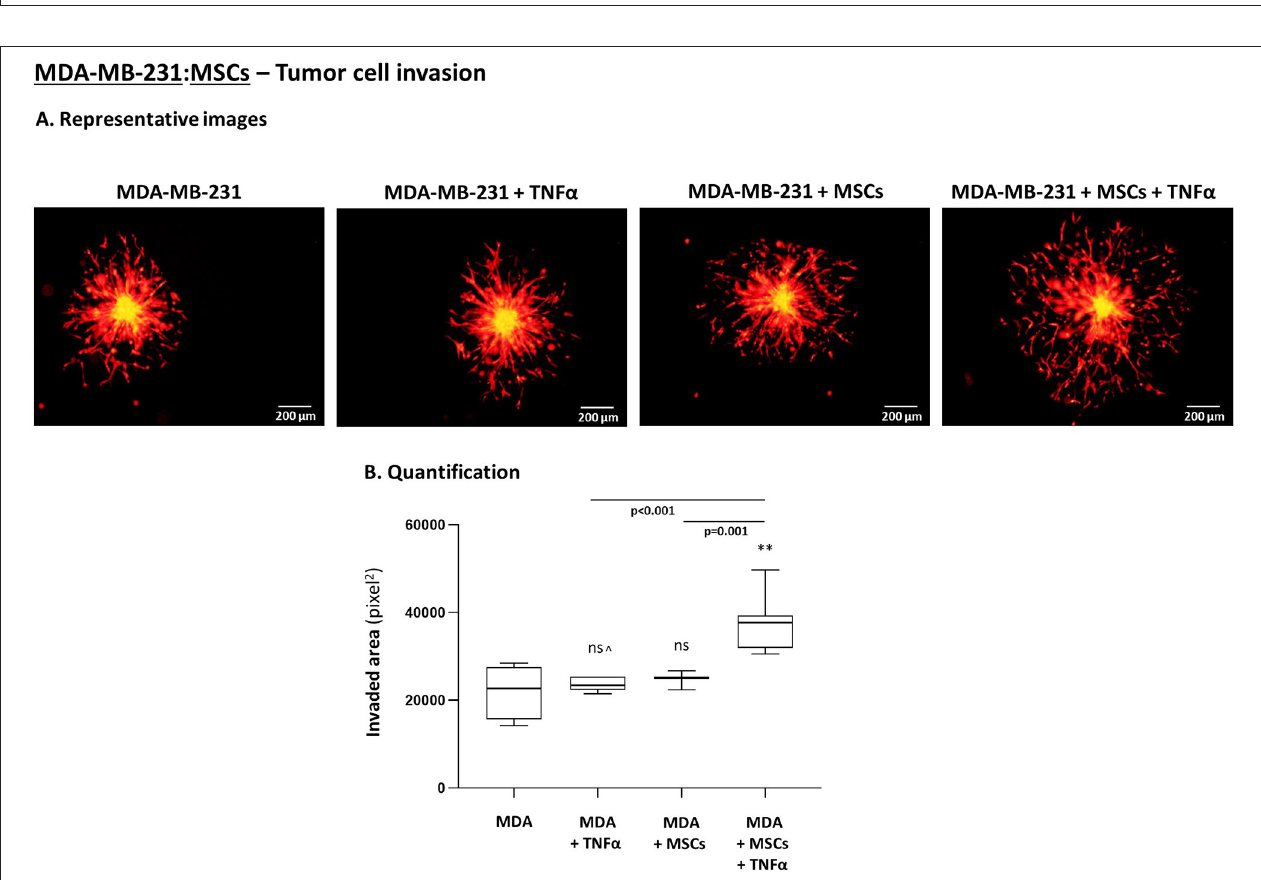
FIGURE 10 | TNBC cells acquire elevated invasive properties upon “Contact” co-culturing with MSCs in the presence of TNF α . The Figure demonstrates tumor cell invasion out of 3D spheroids that were formed by mCherry-MDA-MB-231 cells (“MDA”) alone or by tumor cells in “Contact” co-culturing with MSCs. The spheroids were imbedded into matrigel and then stimulated by TNF α (10ng/ml) or vehicle for 48h. (A) Representative photos. Bar, 200 µ m. (B) Invasion was quantified in multiple spheroids by ImageJ. ** p < 0.01, ns = non-significant for differences between TNBC cell invaded out of spheroids in different combinations, compared to the invasion of non-stimulated TNBC-only spheroids. ∧ See “Note” in legend to Figure 11 . Photos and their quantifications are representatives of n > 3 independent experiments, performed with MSCs of 2 different